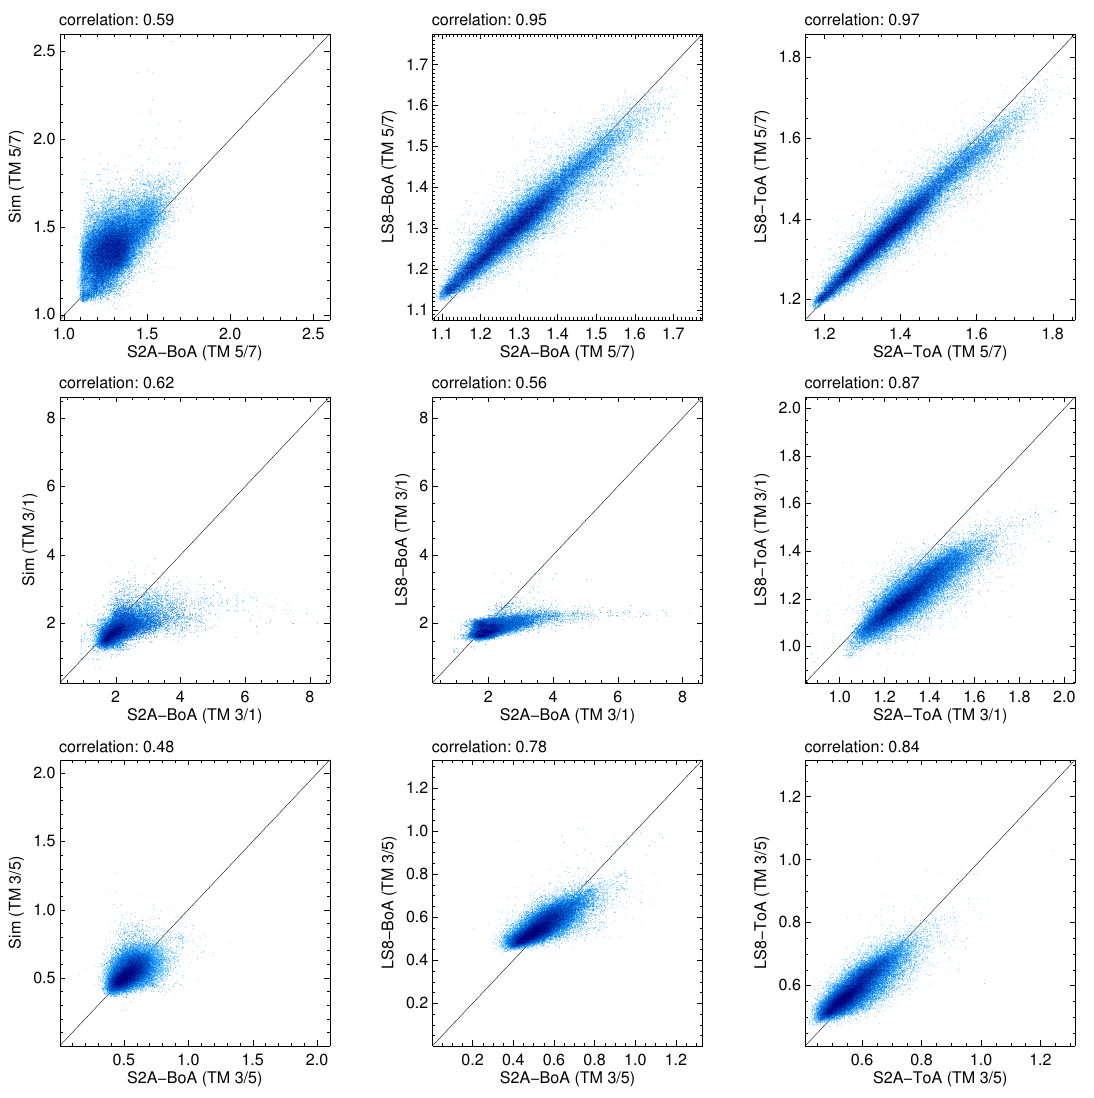
Figure 7. Scatterplots of Sabins’ band ratios made with Landsat 8 OLI, Sentinel-2A MSI and a simulated Sentinel-2A MSI data cube. The top row shows ratio TM 5/7, the centre row shows ratio TM 3/1 and the bottom row shows ratio TM 3/5. It can be observed that the correlation between the top-of-atmosphere reflectance products is higher than the correlation between the bottom-of-atmosphere reflectance